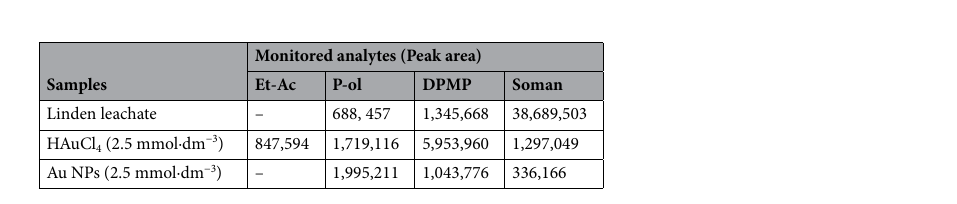
Table 3. SPME monitoring of hydrolysis products after 24 h.